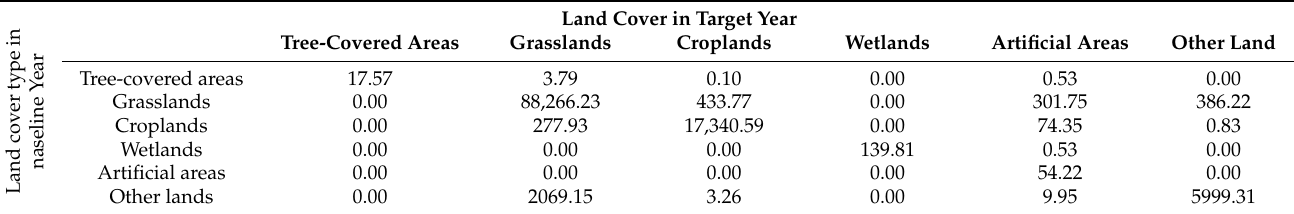
Table 3. Land cover area change matrix (km 2 ).